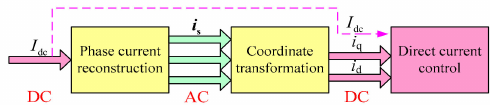
Figure 3. Transformation from sampled current to control